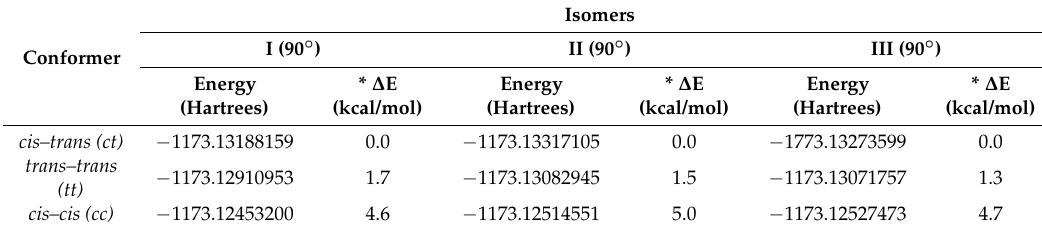
Table 2. Relative energy difference between the conformers when the group –B(OH) 2 is 90 ◦ of the benzene ring in the systems I : ortho , II : meta and III : para . In each case, the dihedral angle is between C12–C13–B–O.